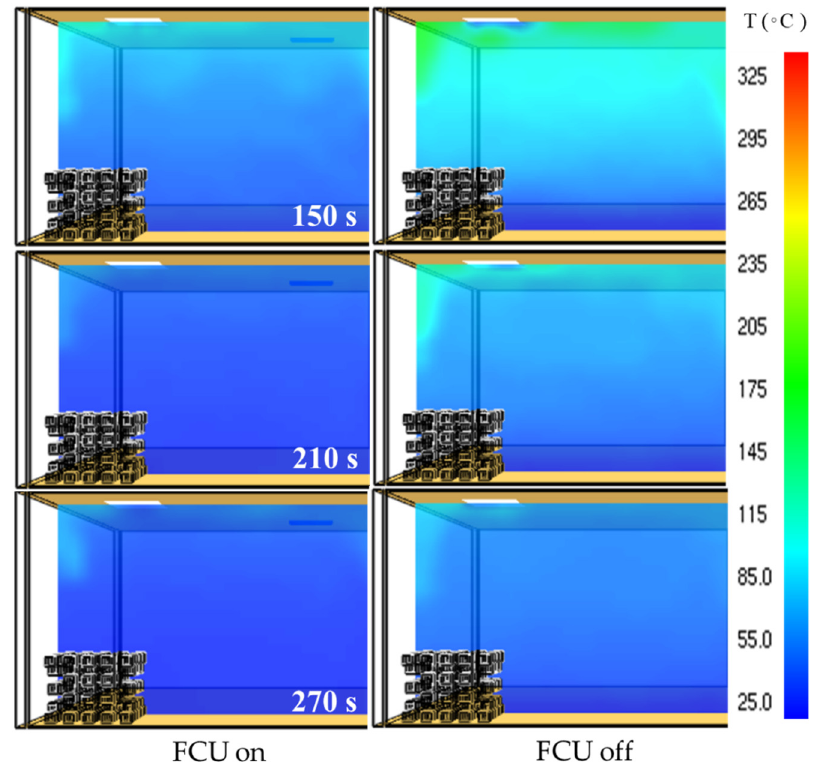
Figure 14. Temperature distribution slices of smoke layer at 150 s, 210 s and 270 s for the two modes in the square room.